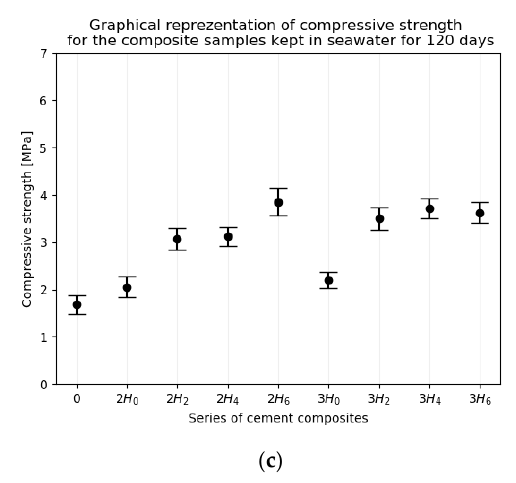
Figure 6. ( a ) Compressive strength data of the 28-day series of composites kept in a moisture chamber; ( b ) Compressive strength data of the 148-day series of composites kept in a moisture chamber; ( c ) Compressive strength data of the 148-day series of composites kept in seawater.